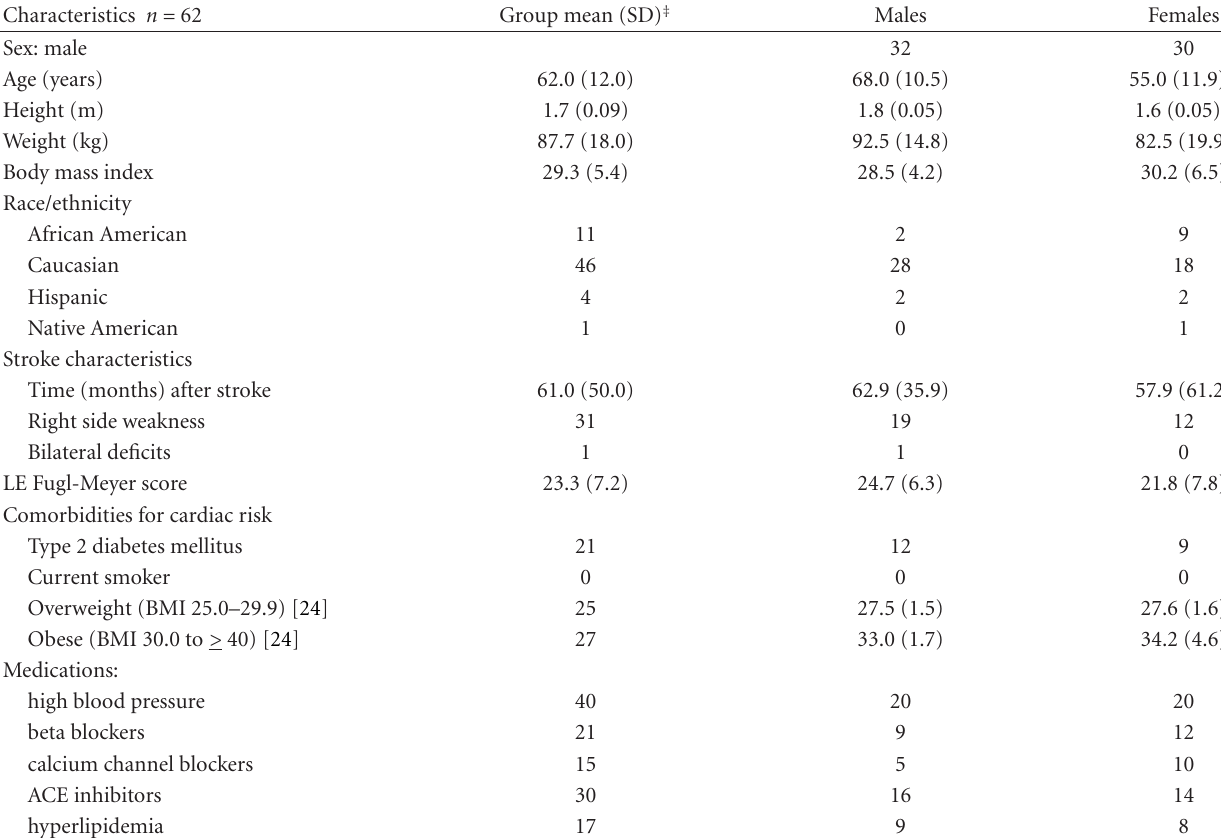
Table 1: Participant